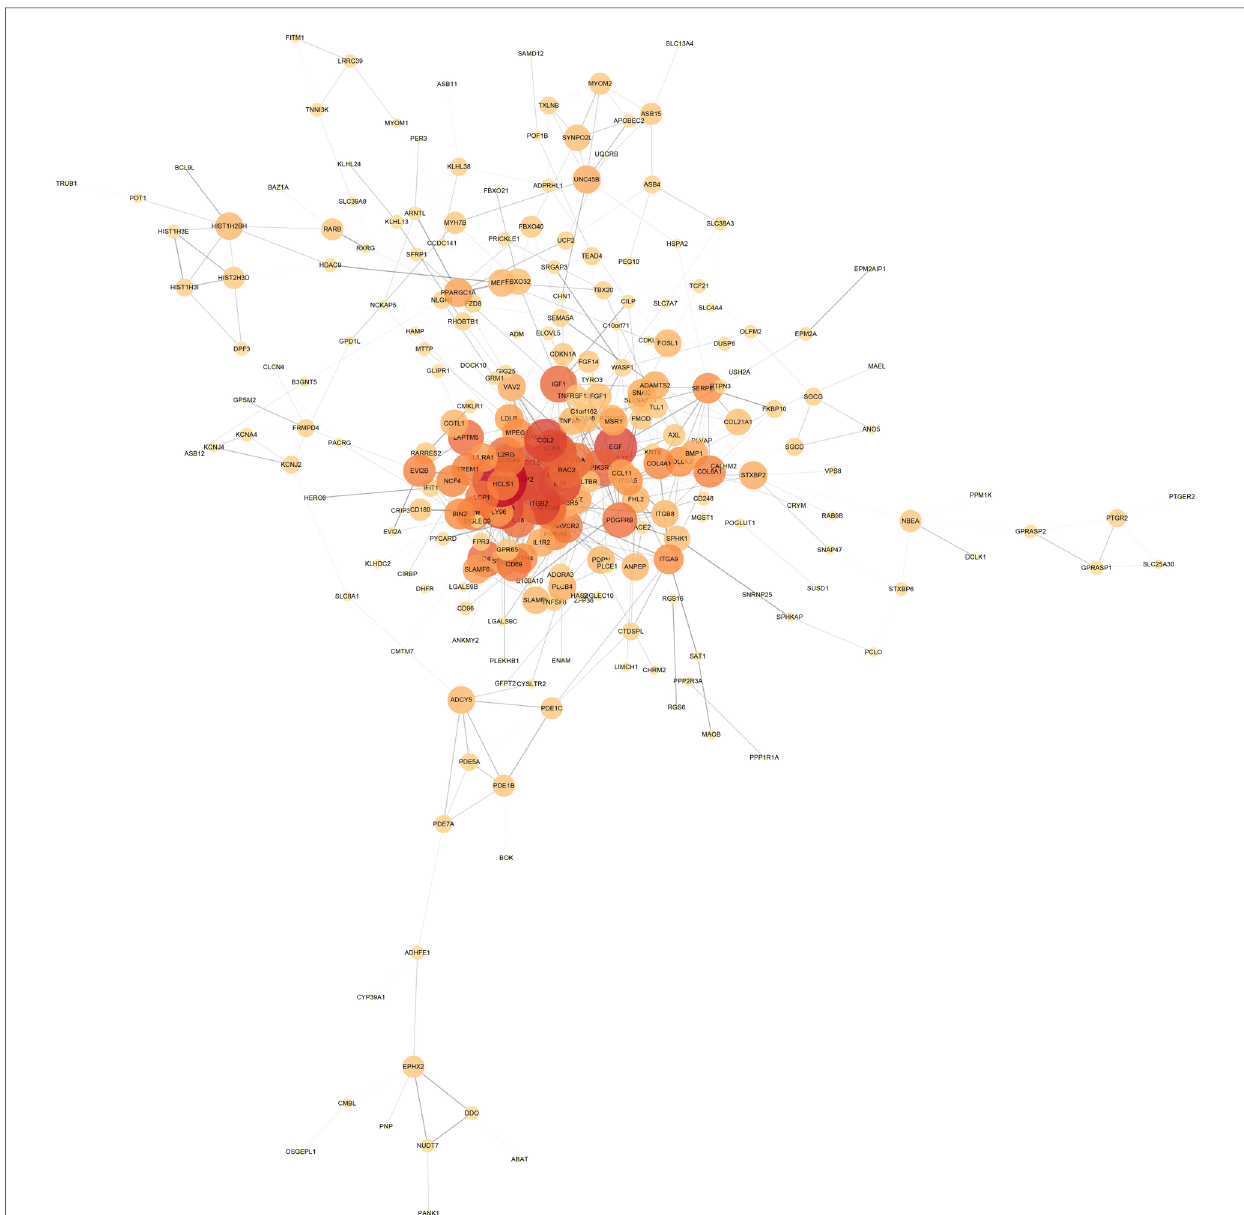
FIGURE 5 PPI network diagram, the darker the color and the larger the circle, the more important the gene; the thickness of the line represents the strength of the binding between